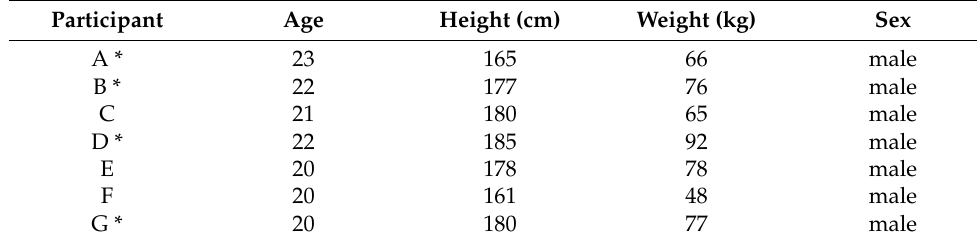
Table 1. Participants involved in the